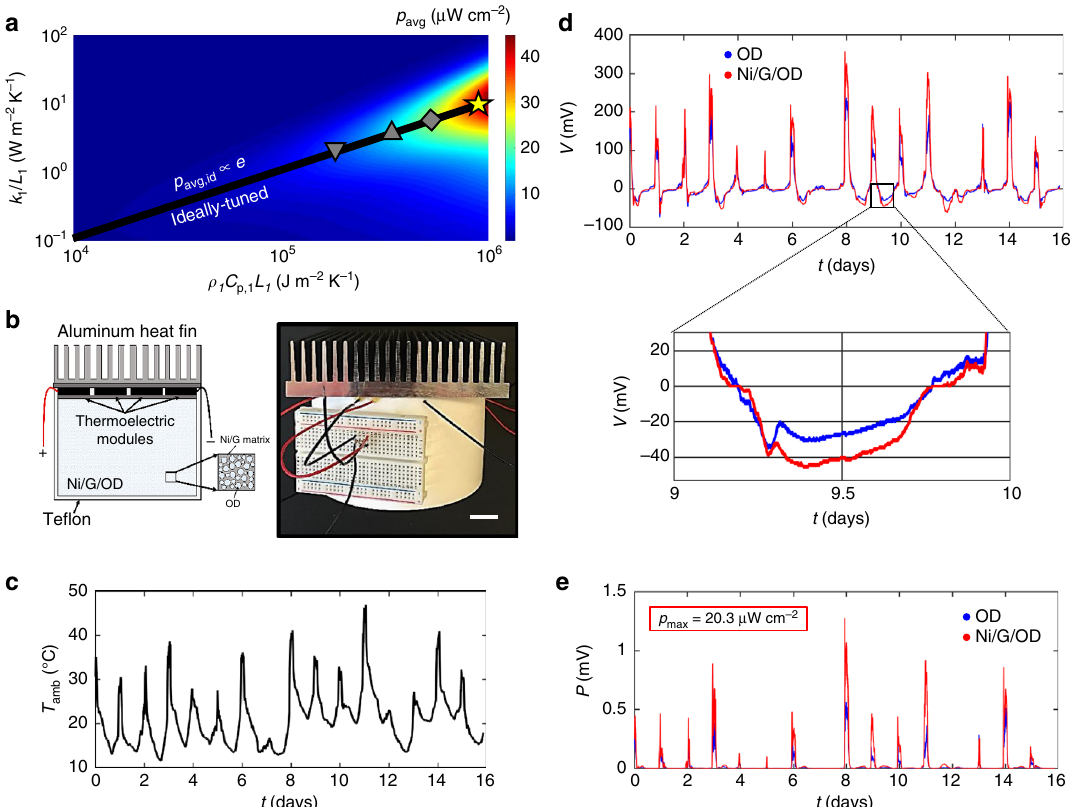
Fig. 6 Reduction to practice of a power-optimized and tuned diurnal thermal resonator. a Heat map for the harvestable power density ( p avg ) from diurnal temperature fl uctuations as a function of quantities related to the thermal resistance and thermal capacitance of thermal mass 1. The heat map assumes a diurnal temperature oscillation frequency ω ¼ 7 ´ 10 (cid:2) 5 s (cid:2) 1 , R (cid:3) 1, and a temperature oscillation magnitude T A = 10 °C. The gray triangle ð ∇ Þ , gray triangle ( Δ ), gray square, and yellow star correspond to ideally tuned dry soil, wet soil, OD, and Ni/G/OD thermal resonators, respectively. b Diurnal thermal resonance devices (schematic, left; photo, right) constructed from a hollow Te fl on cylinder (height = 7.6 cm; diameter = 12.7 cm) and a 14 cm × 14 cm × 2.5 cm aluminum heat fi n with four 4.0 cm × 4.0 cm Bi 2 Te 3 commercial thermoelectrics wired in series as the heat engine situated between the thermal masses. The hollow Te fl on cylinder contains stacked Ni/G/OD (26 pieces, diameter = 8 cm) as the phase change material. A control device containing pure OD was also constructed with the same dimensions (Methods, Supplementary Note 11). Scale bar: 2.5 cm. c Temperature pro fi le of the transient, ambient environment where the diurnal thermal resonance devices were located over the course of 16 days in Cambridge, MA, USA, between 17 May and 2 June 2016. d Closed circuit voltage pro fi les for the diurnal thermal resonance devices when exposed to the ambient boundary conditions shown in c . e Power pro fi les for the diurnal thermal resonance devices when exposed to the ambient boundary conditions shown in